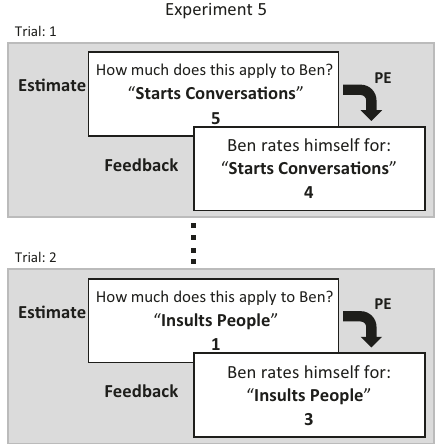
Fig.1|Overviewoftheexperimentaltasks. Inthisstudy,wetestedcomputational modelsofhowhumanslearnaboutothers.In fi vedistinctexperimentsparticipants performed a social learning task on several pro fi les of other persons (with every pro fi le being presented in a separate run). General overview of the learning task: Two trials for Experiment 1 (left) and Experiment 5 (right) are shown. During the learning task, participants estimated which self-ratings a person (here called